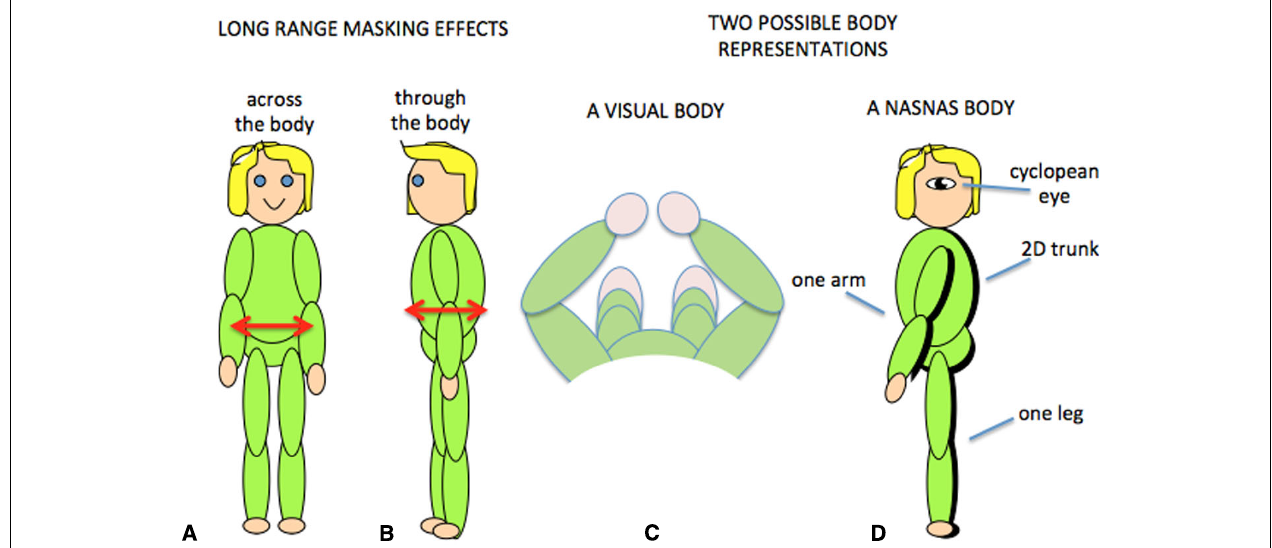
FIGURE 6 | Long-range tactile masking across (A) and through (B) the body. Two possible body representations based on the visual view of the body (C) or the results of contralateral masking which suggest that at some level the body representation may have a single arm and leg and a 2D trunk (D) .